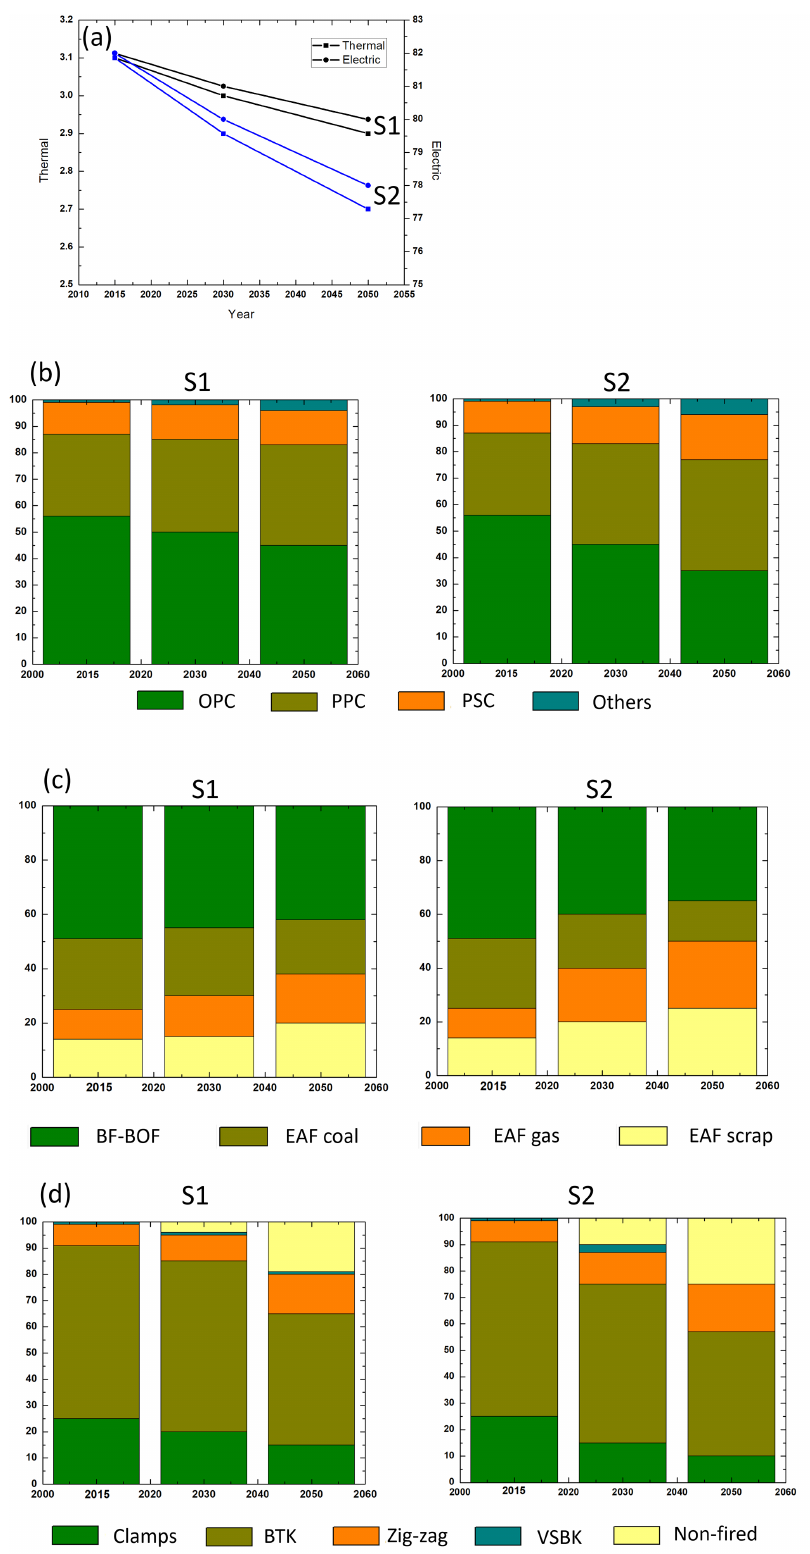
Figure 1. Energy efficiency and technological change assumptions for reference scenario (S1) and moderate energy efficient scenario (S2). (a) Thermal and electric energy efficiency changes from 2015 to 2050 for cement manufacturing. Technological changes from 2015 to 2050 under (b) cement industry, (c) steel industry and (d) brick